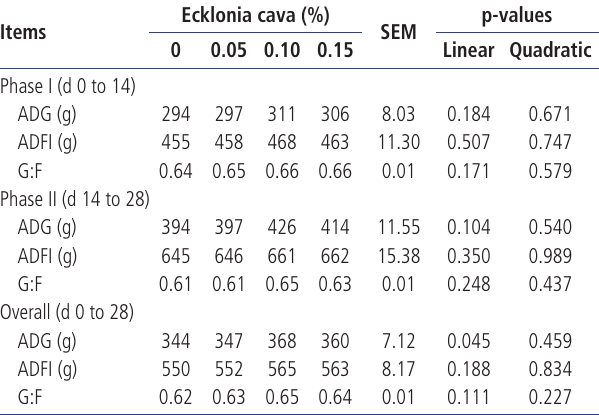
Table 4. Effects of supplemental Ecklonia cava on apparent total tract digestibility (%) of nutrients in weanling pigs